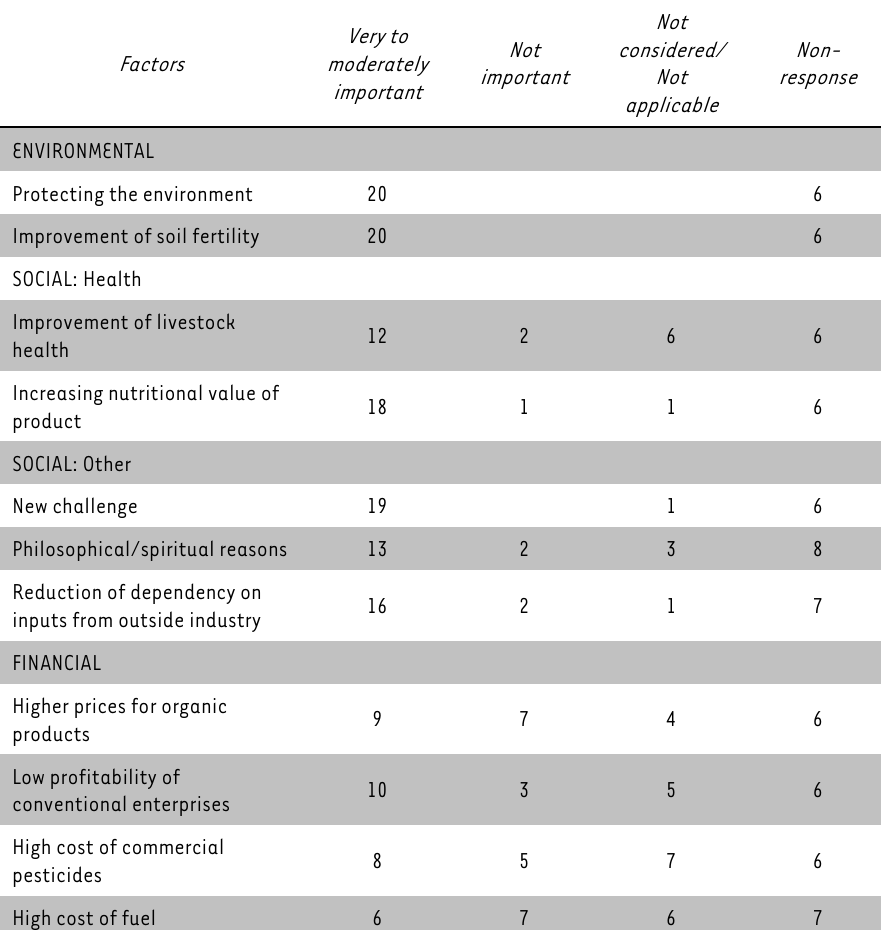
Motivational factors to convert to or use organic agriculture Factors